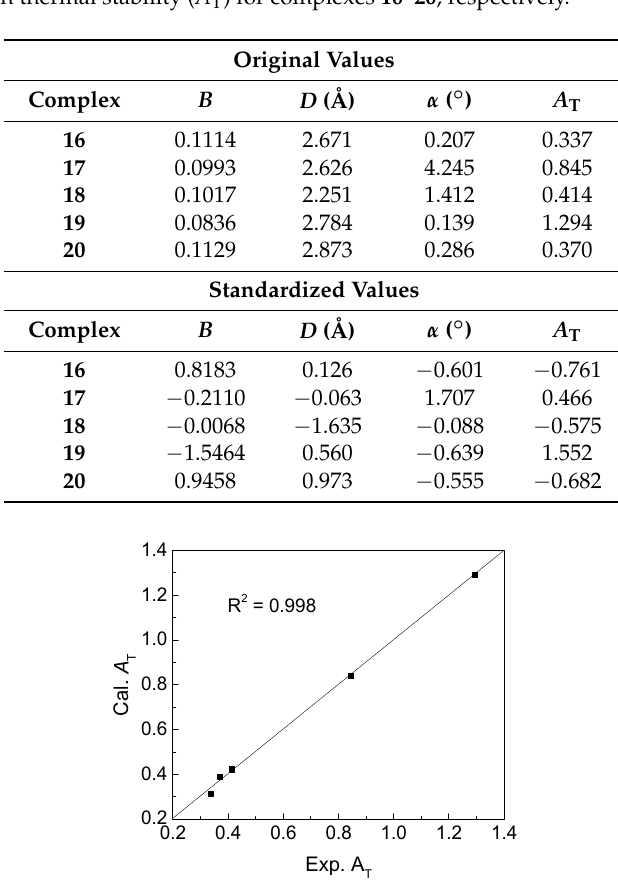
Figure 4. The plot of calculated thermal stability (Cal. A T ) versus experimental thermal stability (Exp. A T ) for complexes 16 – 20 .